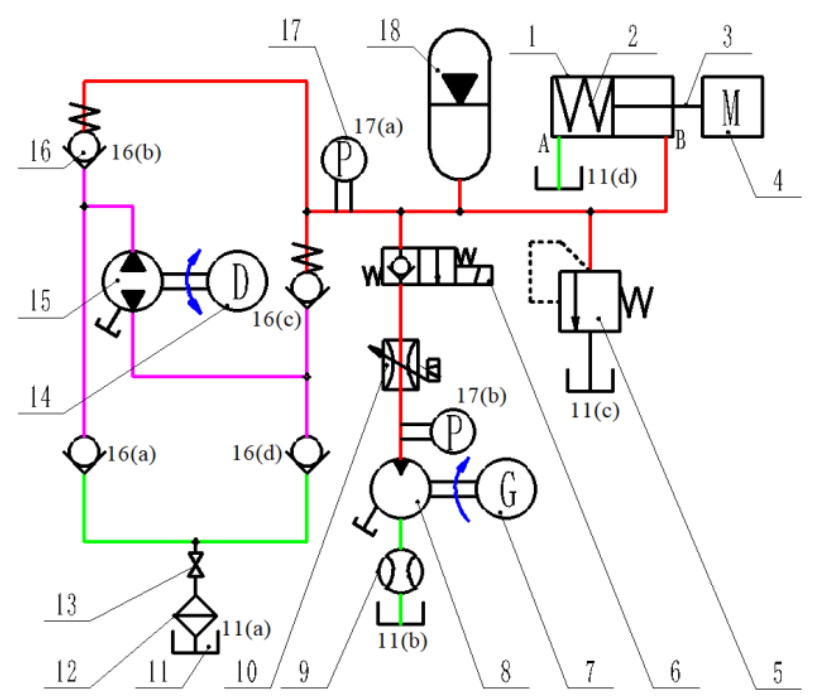
Figure 2. The schematic diagram of hydraulic PTO, 1—hydraulic cylinder for eccentricity regula- tion, 2—spring, 3—piston rod, 4—eccentric rotor, 5—relief valve, 6—electromagnetic switch valve, 7—electric generator, 8—hydraulic motor, 9—flowmeter, 10—proportional flow control valve, 11— oil tank, 12—filter, 13—ball valve, 14—speed increase gearbox, 15—hydraulic pump, 16—check valve, 17—pressure transmitter, and 18—hydraulic accumulator.